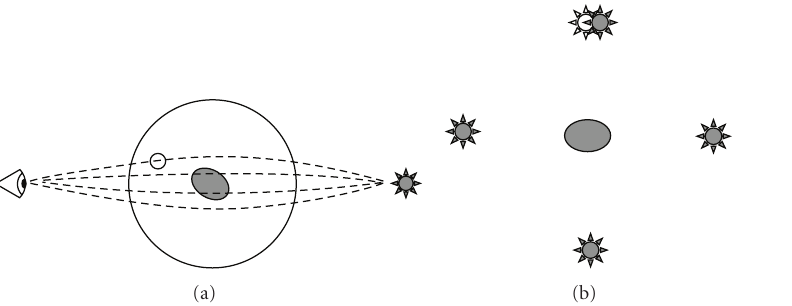
Figure 5: Astrometric perturbations. (a) One of the multiple sightlines towards a distant light source passes through a dark subhalo. (b) The images of the macrolensed source are observed at the positions of the gray source symbols. Modelling of the lens system with a smooth lens potential predicts the position of the upper image at the white source symbol. The subhalo close to the sightline of the image causes a deflection on the order of a few tens of milliarcseconds.